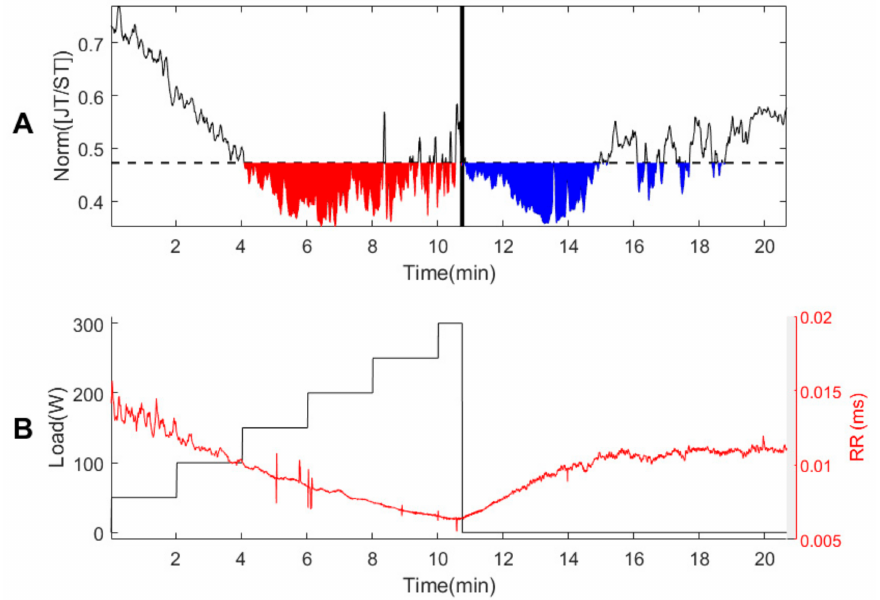
Figure 3. The dynamics of the JT/ST relationship during the load and recovery processes for person #2. The x -axis in parts ( A , B ) represents the time (measured in minutes) from the beginning of the cycle ergometry exercise. The left y-axis in part ( B ) represents the power of the load in Watts. The right y-axis in part ( B ) represents the variation of the RR interval in ms. The algebraic JT/ST relationship is represented by the thin dashed black line in part A. The thick black solid vertical line in part A marks the end of the